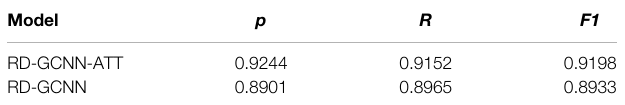
TABLE 8 | Results of the model experiment.